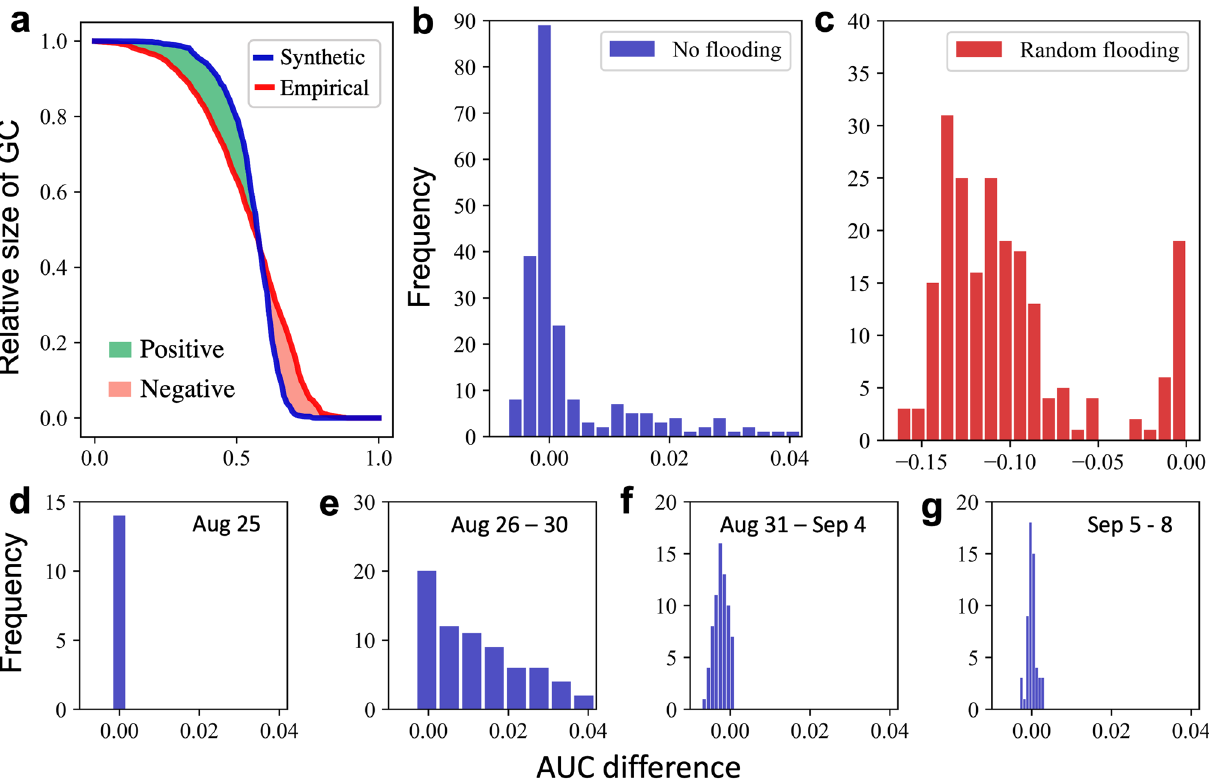
Fig. 7 Flood impact comparison between empirical and synthetic no- fl ooding and random- fl ooding scenarios. a Schematic illustration for robustness AUC difference calculation. The total fl ood impact difference is the summation of the positive (green shade) and negative (red shade) areas. b Histogram of AUC difference between no- fl ooding and empirical- fl ooding case (blue bar). c Histogram of AUC difference between random fl ooding and empirical fl ooding case (red bar). d – g The AUC difference frequency during different time